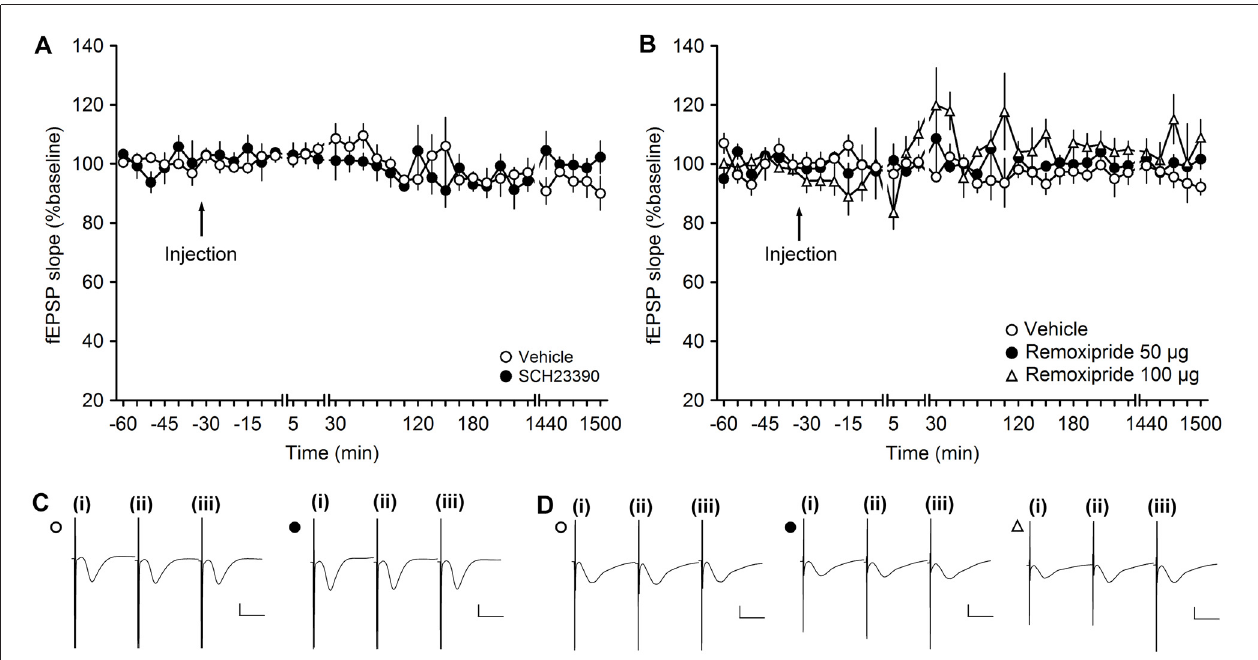
FIGURE 1 | The D1/D5 receptor antagonist SCH23390 and the D2/D3-receptor antagonist remoxipride have no effect on basal synaptic transmission. (A,B) In vehicle-injected animals, test-pulse stimulation evoked stable field excitatory postsynaptic potential (fEPSP) responses for the duration of the monitoring period. Injection of the D1/D5 receptor antagonist (A) or the D2/D3-receptor antagonist remoxipride (B) had no effect on evoked responses. Line breaks indicate change in time scale. (C) Analog responses were obtained during a control experiment (open circle) and during an SCH23390 experiment (filled circle); (i) pre-injection; (ii) post-injection; and (iii) 24 h post-injection. Vertical scale bar: 1 mV, horizontal scale bar: 10 ms. (D) Analogs depict traces recorded from animal in control experiments (open circle), during an experiment with 50 µ g Remoxipride (filled circle) and 100 µ g Remoxipride (open triangle); (i) pre-injection; (ii) post-injection; and (iii) 24 h post-injection. Vertical scale bar: 1 mV, horizontal scale bar: 10